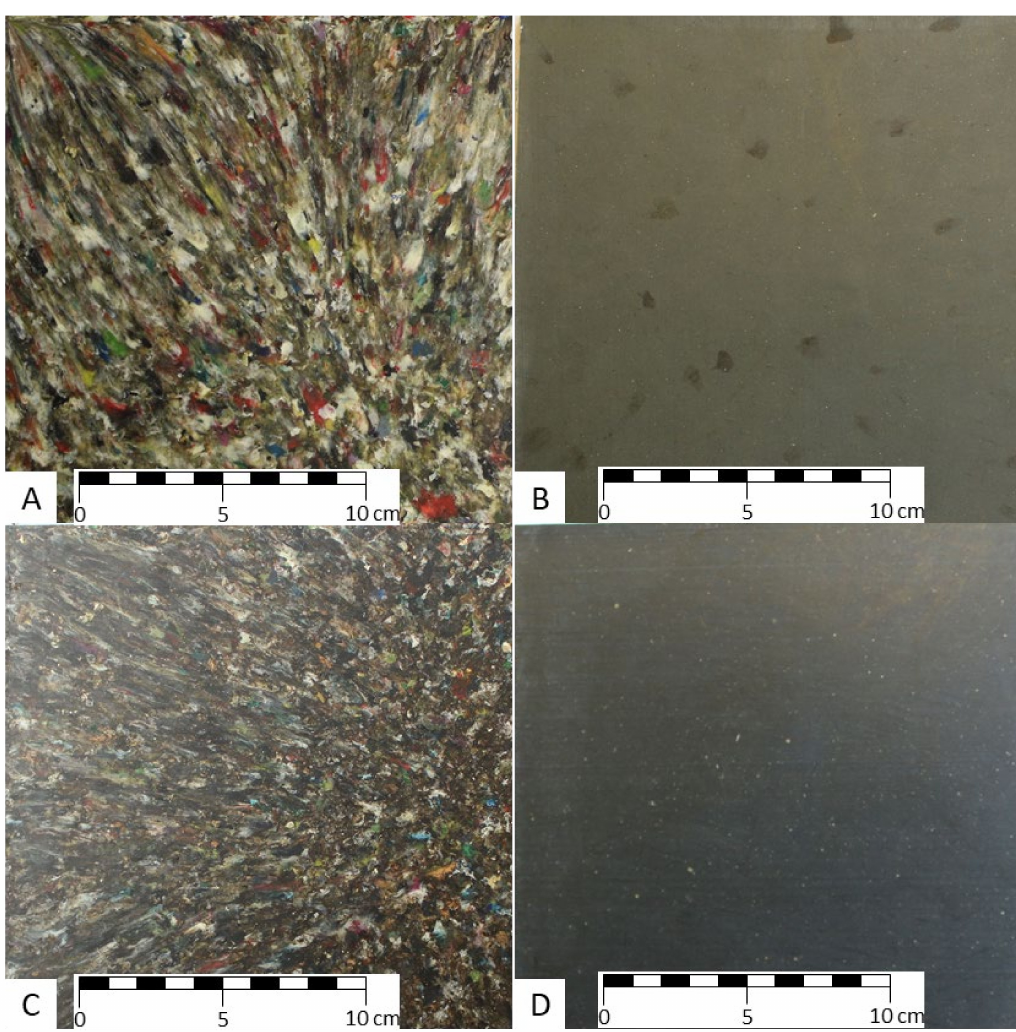
Figure A9. Exemplary photos of vacuum compression moulded plates: PO_B— A ; PO_B,W— B ; P— C ; and P_C— D .